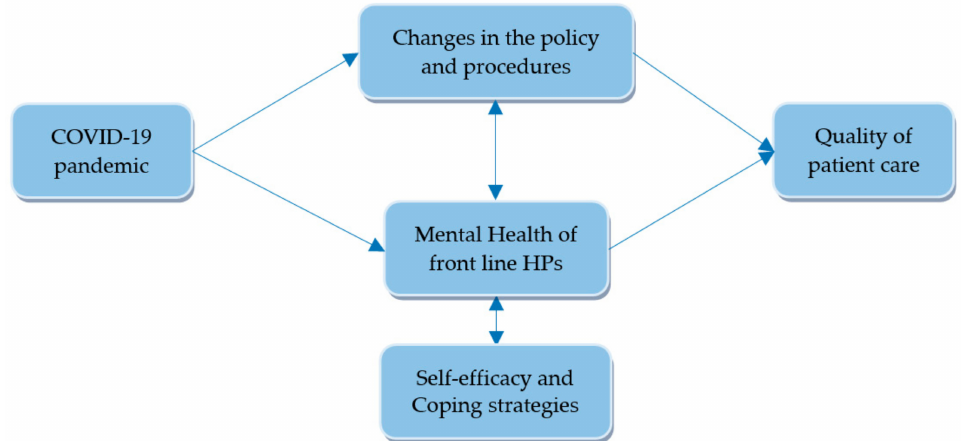
Figure 2. Diagram illustrating the impact of the COVID-19 pandemic on the healthcare system and mental health of front-line